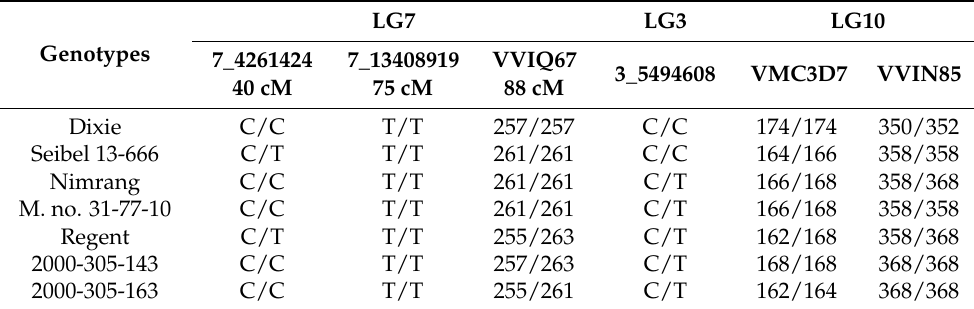
Table 2. Polymorphism of parental lines and their ancestors revealed using SNP and SSR markers linked to phylloxera resistance loci identified [12] on chromosomes LG7, LG3, and LG10 respectively. LG7 LG3 Genotypes